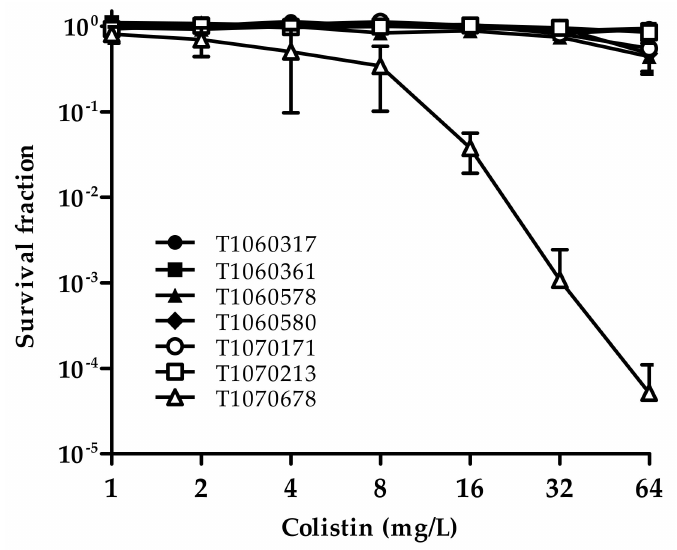
Figure 5. Population analysis profiles of the CCR-AB isolates. An overnight culture of each isolate was serial diluted 10-fold. The diluted bacterial suspension was plated onto LB agar, with colistin concentration ranging from 0 to 64 mg/L. CFU was counted in each agar. The survival fraction in each colistin concentration was calculated by comparing it to CFU on colistin-free medium. The results present the average of three replicates with standard errors depicted by the error